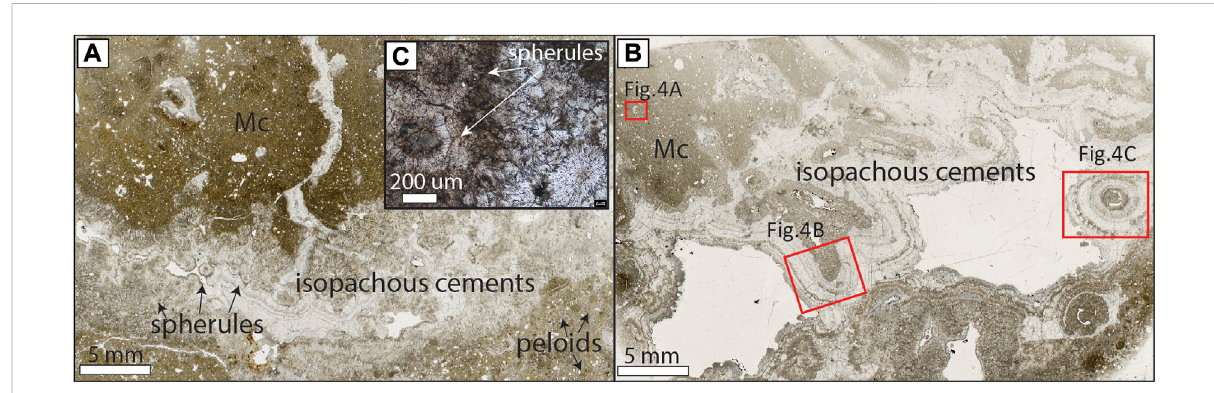
FIGURE 3 Thin section scans from sample CarC-05 collected from the top of a carbonate body. (A) Thin section CarC-05- A displaying a dark-brown microcrystalline carbonate (Mc) locally displaying peloidal features and crosscut by veins fi lled by isopachous cements. (B) Thin section CarC-05- C showingtheareasanalyzed via EBSD,targetingmicrocrystallinecarbonateandisopachouscements (C)